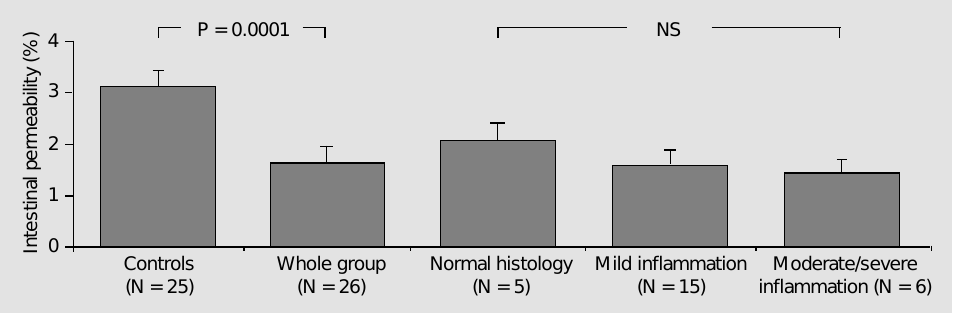
Figure 1 - Intestinal permeability in strongyloidiasis. Urinary ex- cretion of 51 Cr-EDTA is reported as percentage of total adminis- tered radioactivity (mean ± SD) in patients with strongyloidiasis (whole group, normal histology, mild and moderate/severe chron- ic duodenitis and jejunitis). In- testinal permeability was sig- nificantly reduced in patients with strongyloidiasis; there was a negative correlation between intestinal permeability and in- flammation but the values were not statistically significant. NS,